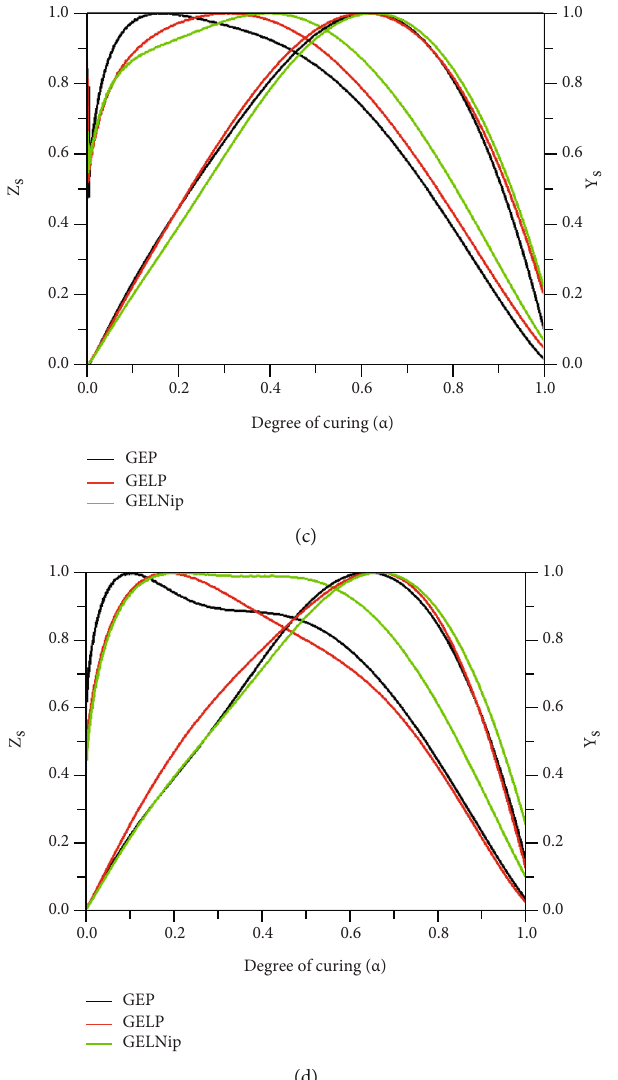
Figure 11: Typical plots of variation of Y ð α Þ and Z ð α Þ versus conversion for GEP, GELP, and GELNiP Ni nanocomposites based on the Malek model at heating rate of (a) 5, (b)10, (c) 15, and (d) 20 °